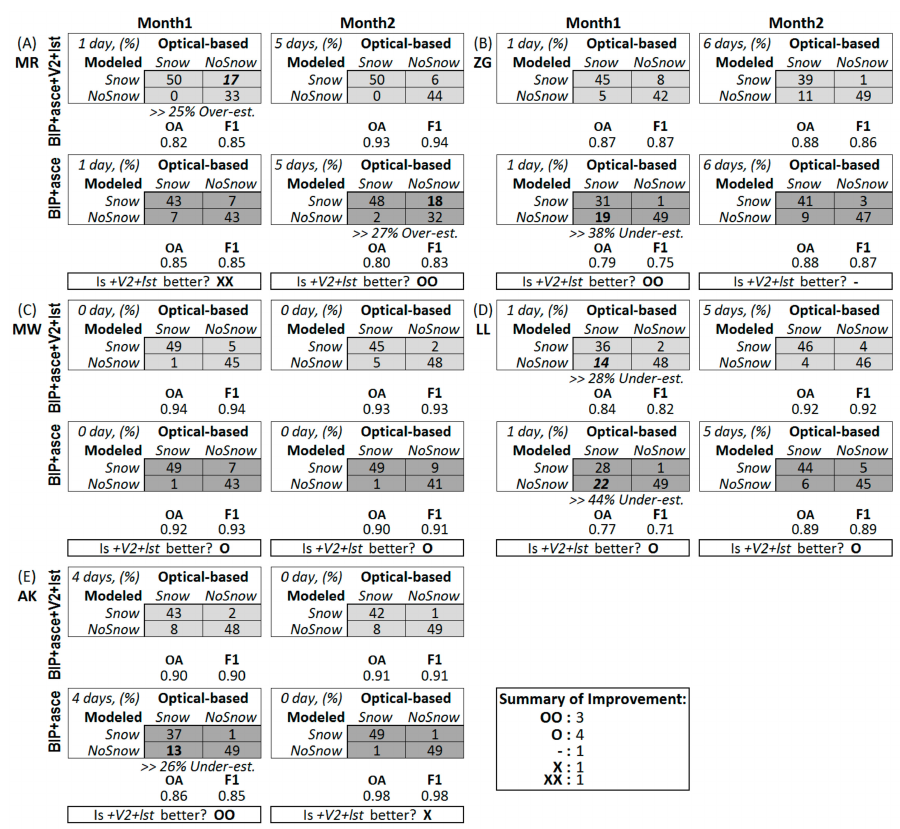
Figure 4. Confusion matrix of the accuracy assessment relying on optical-based snow cover classifications of Landsat and Sentinel-2 for each test site. The assessment includes classifications for months that were trained in the first year (month2) as well as those that were not used in the training of the first year (month1). Overall accuracy (OA) and F1-score are depicted under the respective confusion matrix. The temporal di ff erence (days) between SAR observation image and optical image used for validation is mentioned on the upper-left corner of each confusion matrix. The summary of improvement depicts the improvements achieved by adding vegetation indexes and temperature information: “OO” for major improvement, “O” for slight improvement, “-“ for no change, “X” for slight degradation, and “XX” for major degradation. The confusion matrixes marked in light and dark grey colors represent the results of using the present and previous [18] variable combination, respectively.